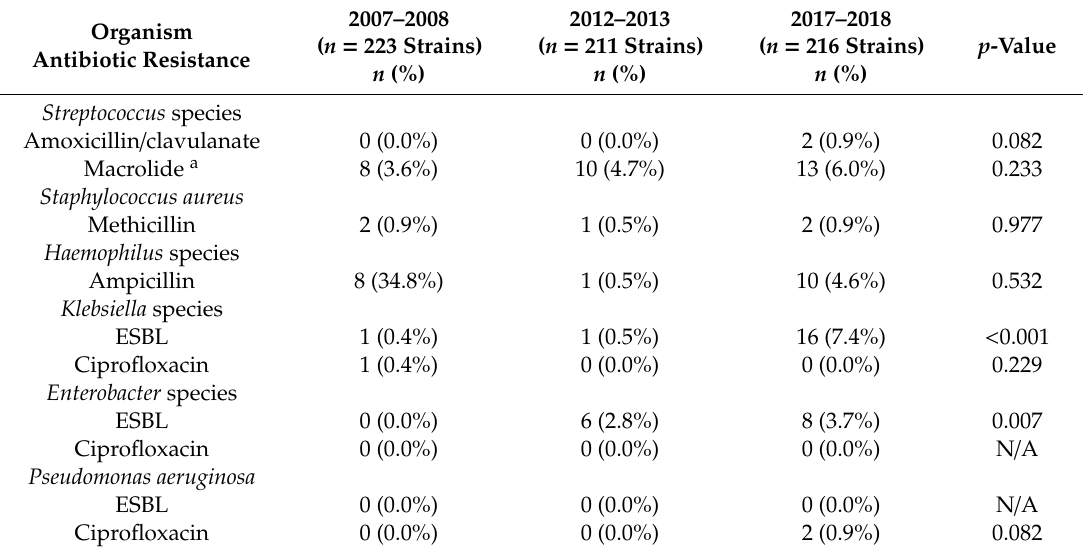
Table 6. Trends in the antibiotic resistance of frequently cultured bacteria over time.